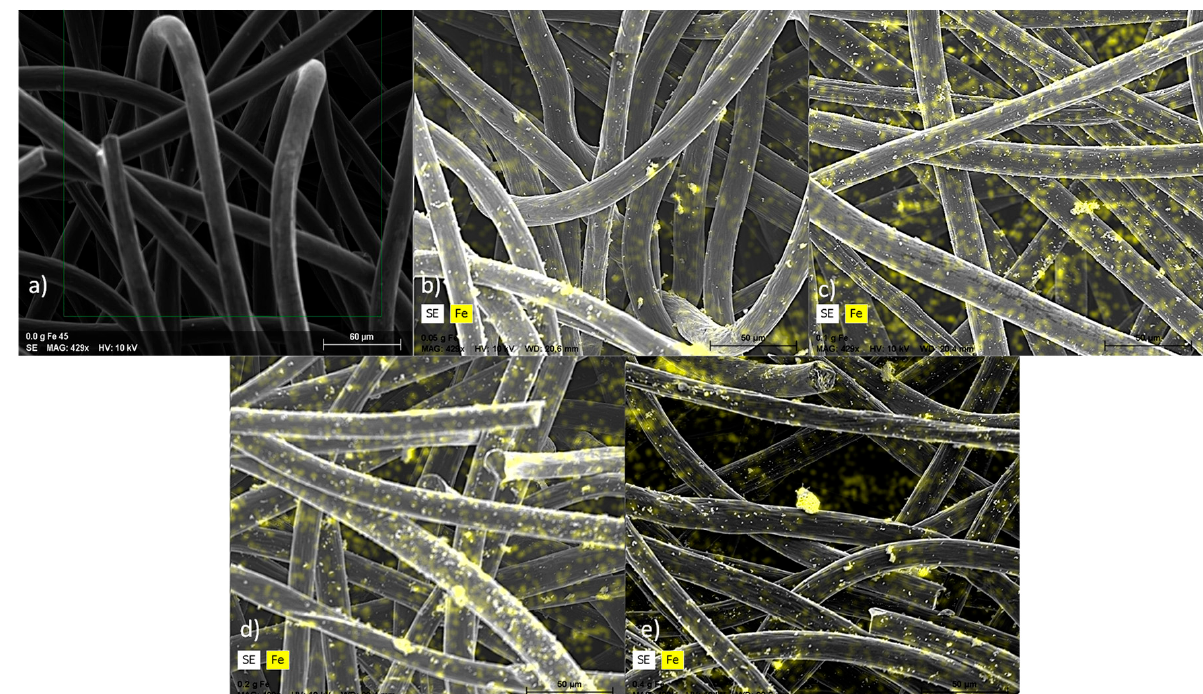
Figure 1. SEM/EDS analyses of anodes’ surfaces for an acceleration voltage of 15 kV ( a ) pristine, ( b ) with 0.05 g Fe 2 O 3 , ( c ) with 0.1 g Fe 2 O 3 , ( d ) with 0.2 g Fe 2 O 3 , and ( e ) with 0.4 g Fe 2 O 3 .